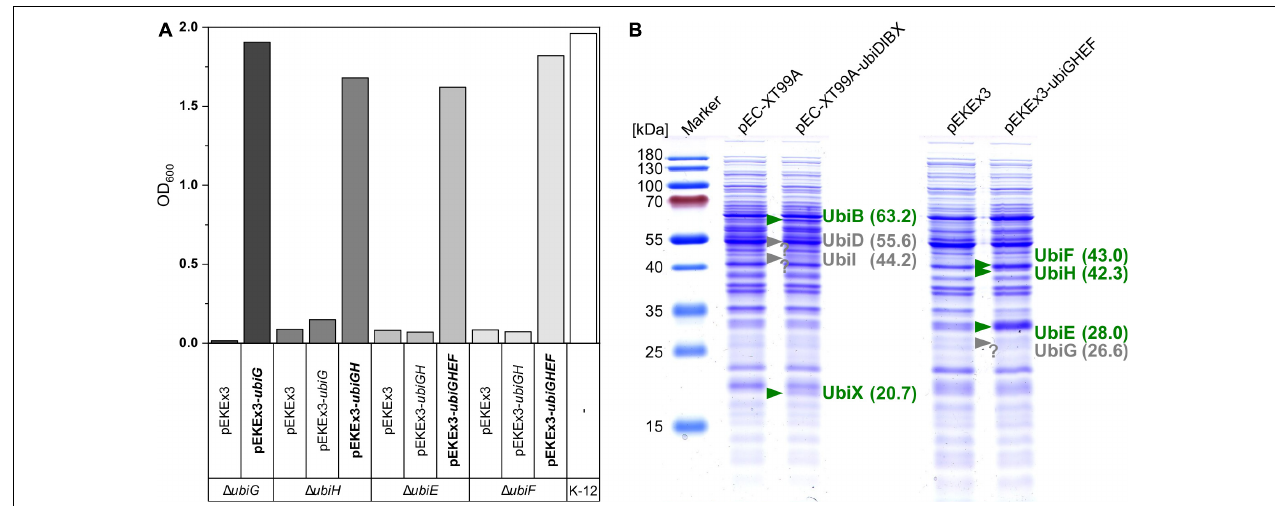
FIGURE 6 | Verification of ubi gene function and expression. (A) E. coli deletion mutants were transformed with control vectors and complementation vectors (bold) and inoculated into M9 minimal medium with 20 mM succinate as sole carbon source. Complementation enabled growth after 45/48 h as can be compared with the positive control strain K-12. (B) SDS–PAGE of UBI000 crude extracts carrying different vectors for expression analysis. Confirmed expression based on theoretical protein weights is depicted in green, missing bands are shown in gray at the expected